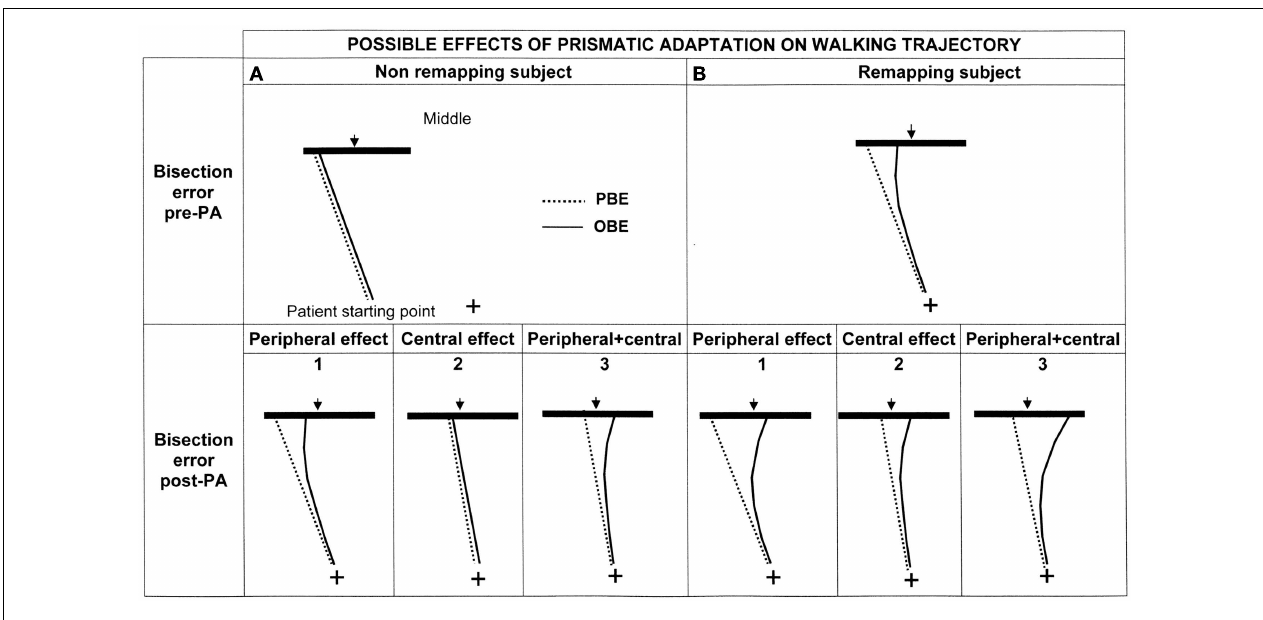
FIGURE 5 | Graphic representation of the possible effects of PA on the walking trajectory of patient MR depending on the presence (B: upper right panel) or absence (A: upper left panel) of spatial